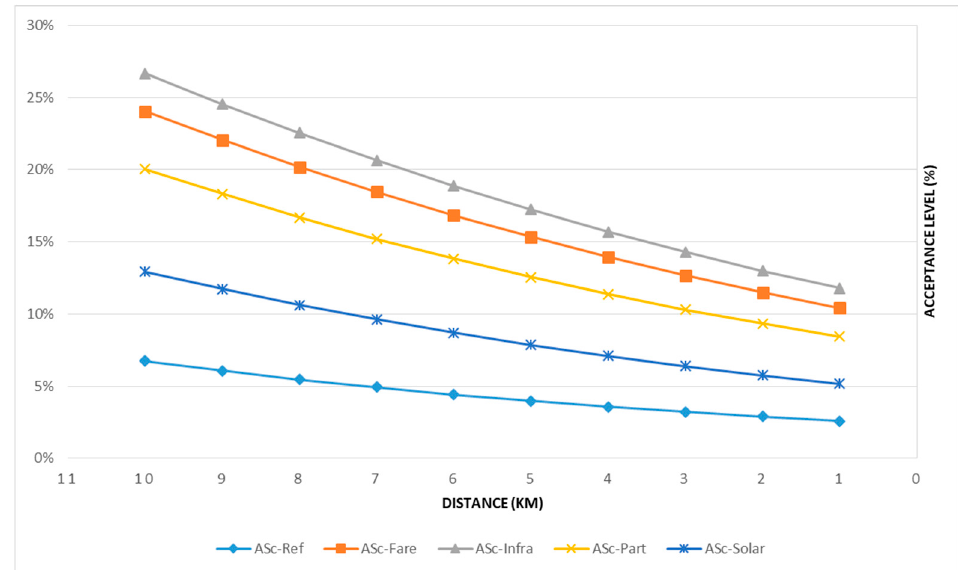
Figure 1. Prediction of NPP acceptance based on the incentives for surrounding